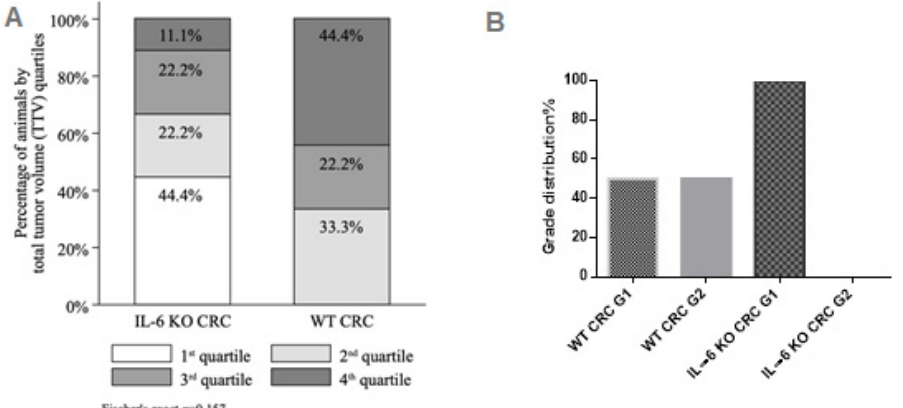
Figure 2. ( A ) Total tumor volume (TTV) quartiles by IL-6 status (IL-6 KO CRC n = 9, WT CRC n = 9) with Fisher’s exact test; ( B ) tumor grade distribution.